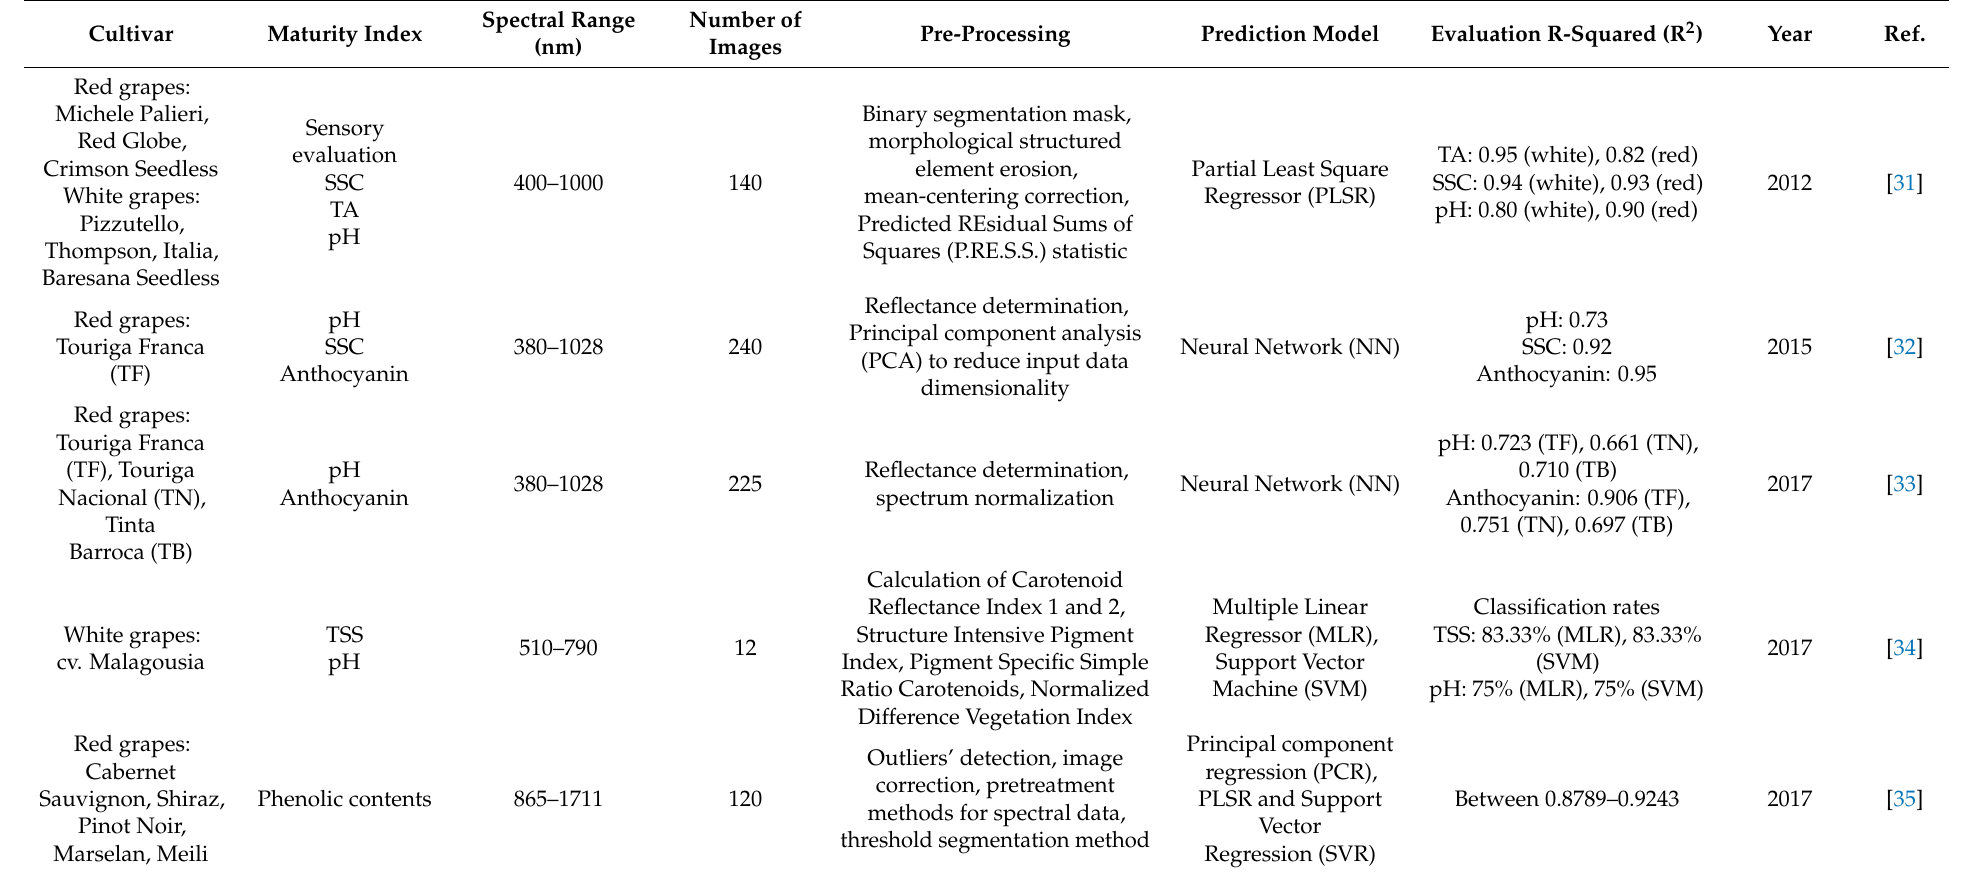
Table 5. Applications of hyperspectral imaging for grape ripeness